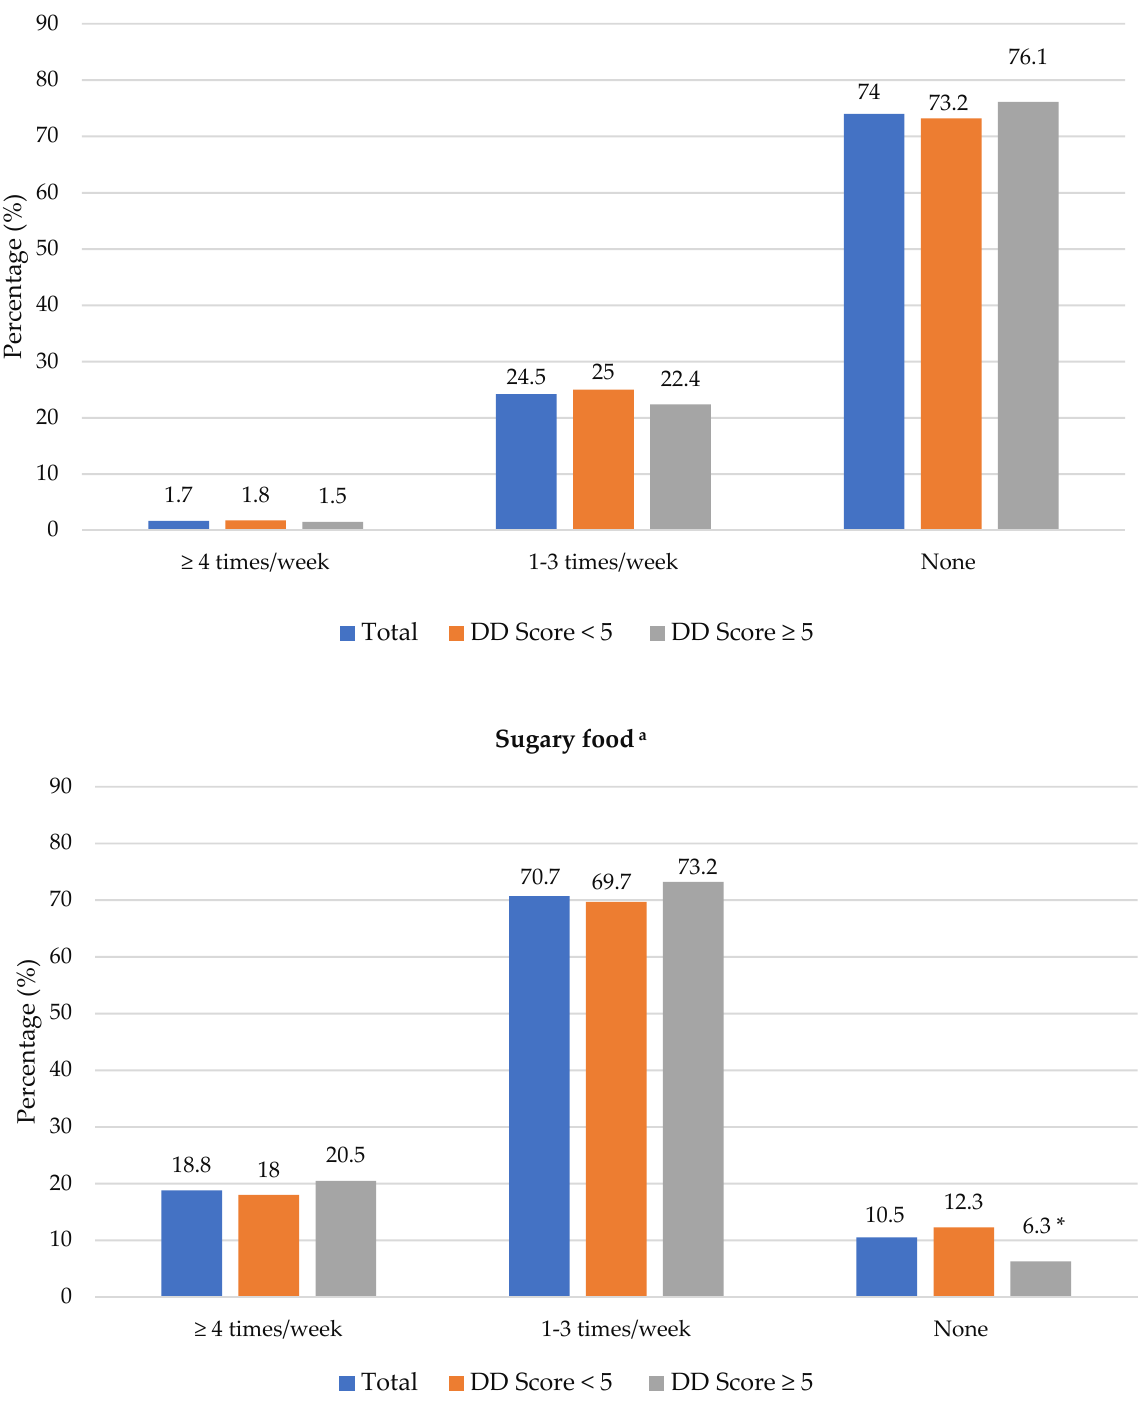
Figure 3. Frequency intake of selected unhealthy foods by dietary diversity (DD) score categories. * Significant difference between DD score categories at p < 0.05 level; a Based on a calculated sugary food score.